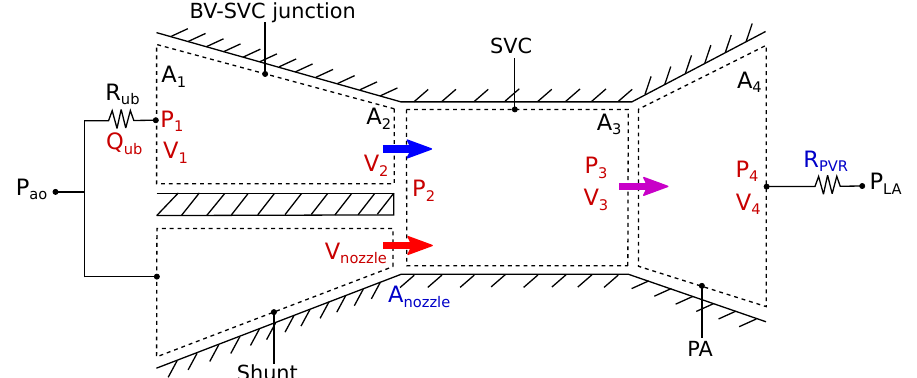
Figure 5. Schematic of the algebraic model for modeling the ABG circulation. Variables shown in black, red, and blue are known, unknown, and independent parameters, respectively. Note that the 2D representation of this schematic is only for demonstrating the control volumes. The algebraic model is a 0D model that does not capture variation in time or